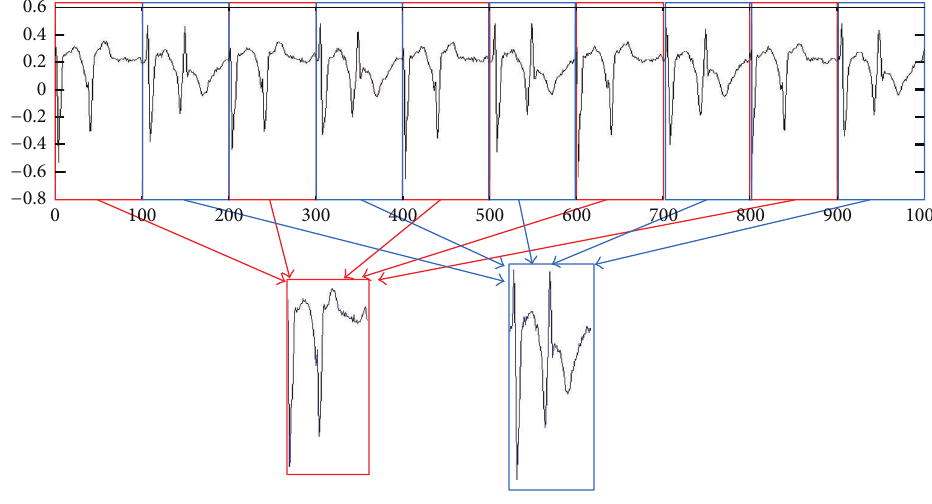
Figure 2: A sample of subsequence time series clustering.